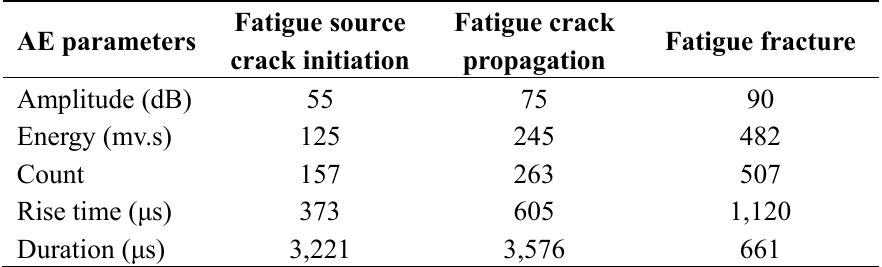
Table 2. The AE signal mean values characteristic parameters range at different fatigue damage